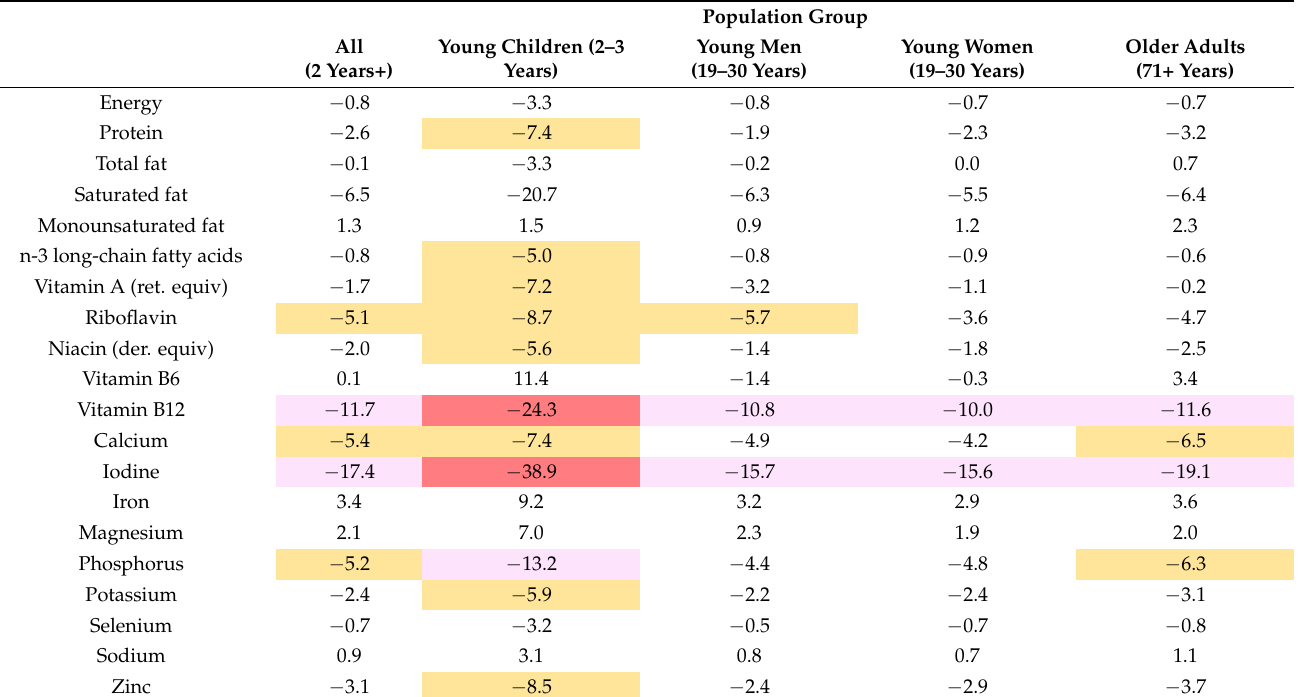
Table 6. Estimated percentage change 1 in mean daily intake of ‘Key Nutrients’ if all ‘Easily Swappable Dairy Milk’ is replaced with plant-based ‘milk’ (Accelerated Milk